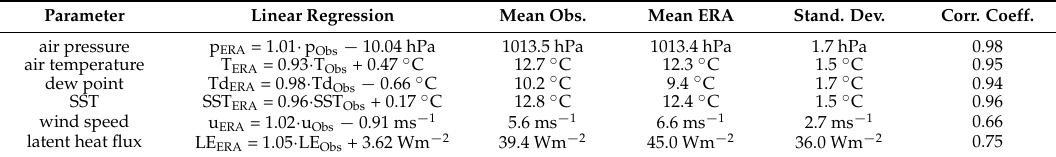
Table 4. Comparison of ERA-Interim (ERA) air pressure p, 2 m air temperature T, 2 m dew